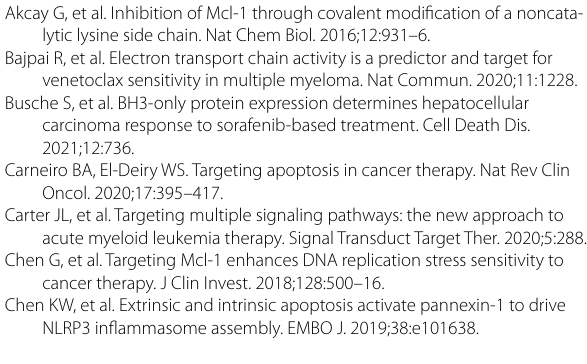
of apoptosis analysis by annexin V/PI staining in Molm13 cells treated with indicated concentrations of MI-238 and venetoclax or their combinations. Fig. S5. The activation of Bak in Molm13 cells after 24 h of indicated treat- ment was analyzed by flow cytometry. Fig. S6. The representative annexin V/PI staining profiles of primary patient AML cells treated with indicated concentrations of MI-238 for 48 h. Fig. S7. 20 μM of MI-238 failed to induce apoptosis in mononuclear bone marrow cells from healthy